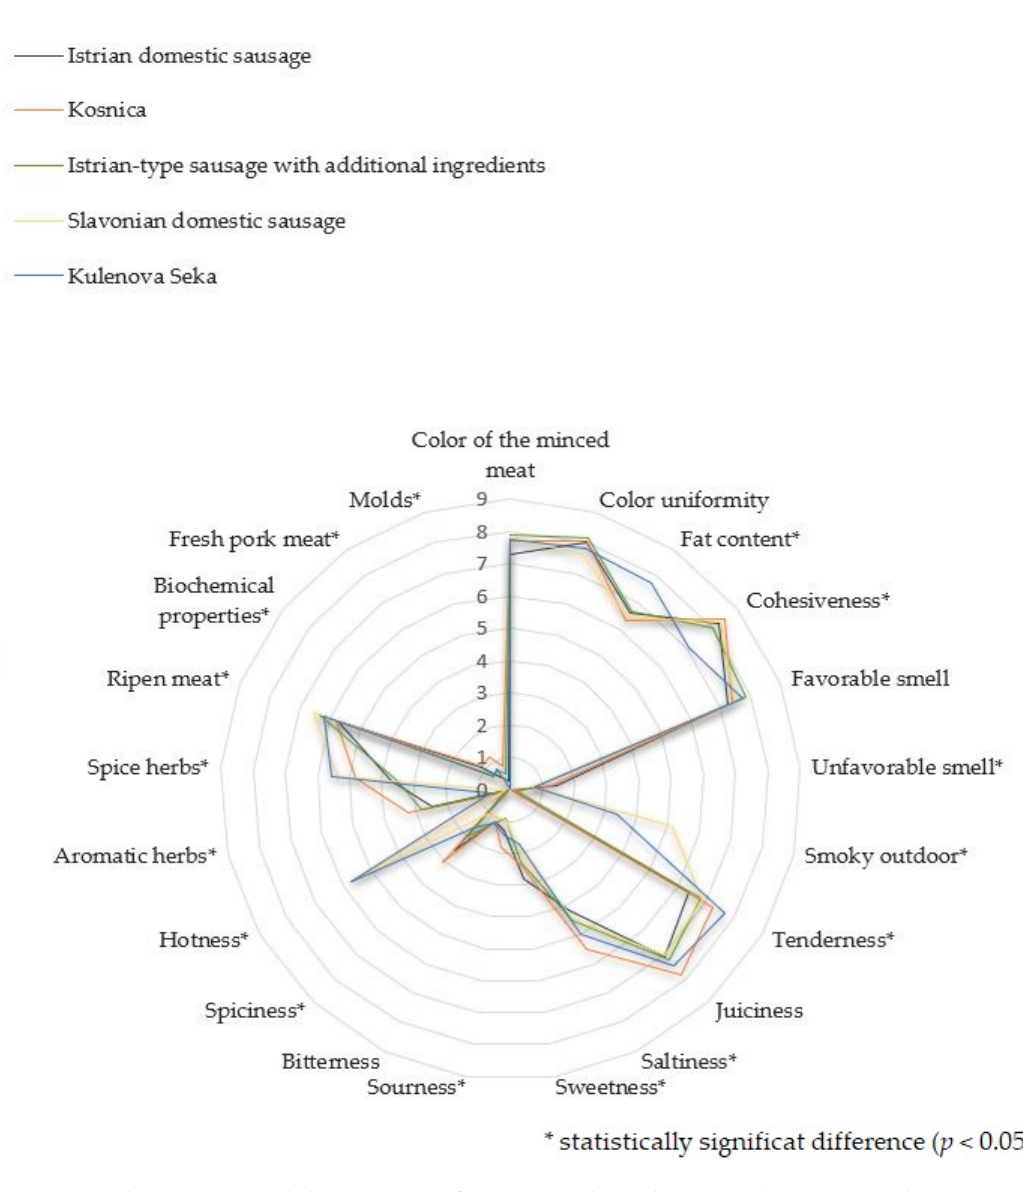
Figure 1. Objective sensorial characteristics of Croatian traditional sausages (appearance, odor, texture, taste and aroma).